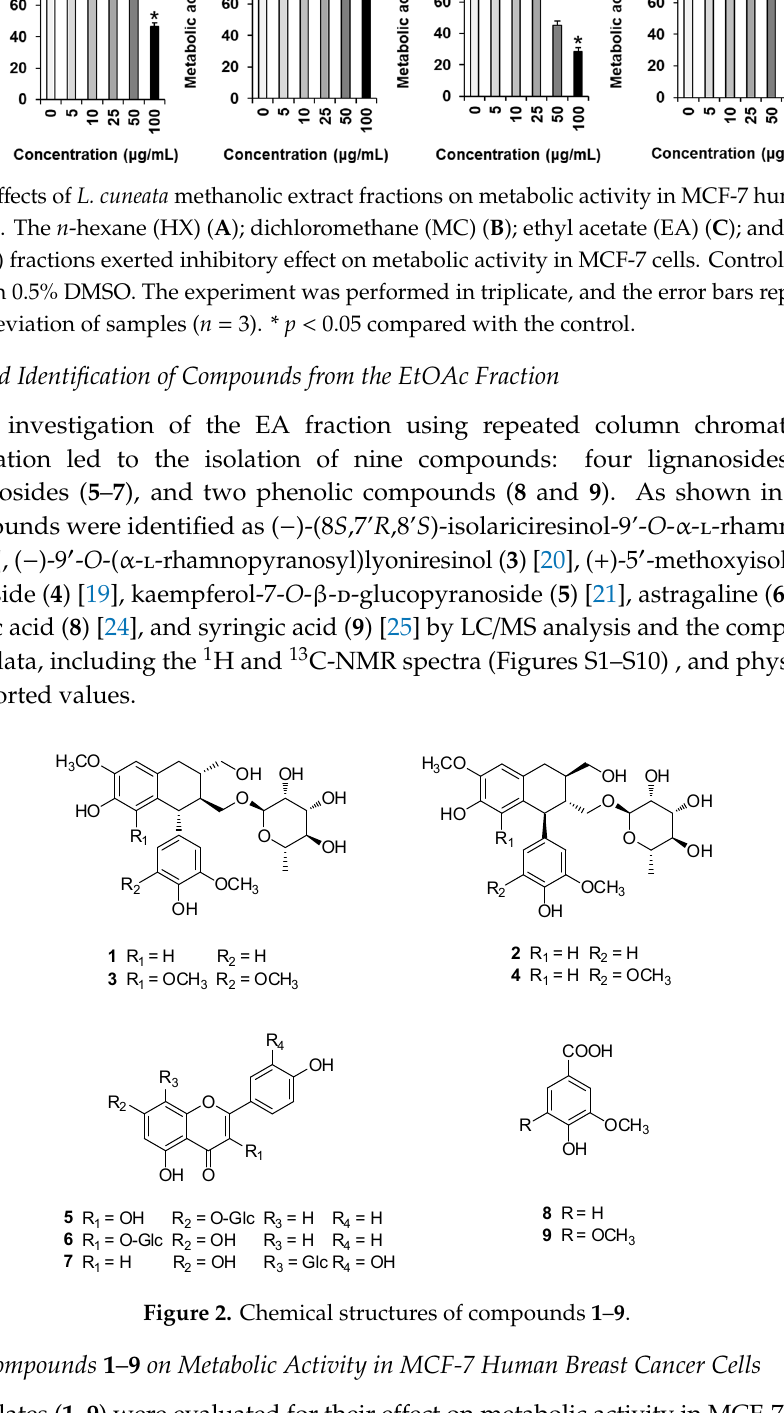
Figure 2. Chemical structures of compounds 1 – 9 .